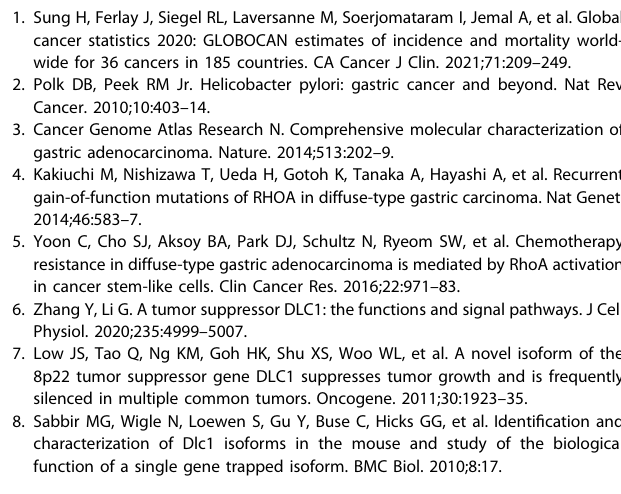
Fig. 6 DLC1 interacts with CagA. A Scheme of DLC1 and CagA expression constructs. Legend: SAM = sterile-alpha motif, RHO-GAP = RHO GTPase-activating protein (catalytic domain for RHO inhibition); START = StAR-related lipid-transfer (domain), Cav1bm = caveolin-1 binding motif, EPIYA = Src kinase tyrosine phosphorylation motif; grey = multimerisation domain. B , C CagA interacts with DLC1. HEK293T cells were transfected with CagA-FL (aa 1-1216), CagA-NT (aa 1-877), or CagA-C (aa 838-1216), combined with DLC1v1 or v4 expression plasmids, respectively. CoIP was performed on cell lysates using Abs against CagA, DLC1 (v1) and FLAG (v4). Quantitative analyses ( B ) and representative images ( C ) from Western blots (Source fi le: “ Original Western Blots ” page 15 – 17). OD values from gels were normalised to ERK1/2 (as loading control) and presented as -fold ± S.E. (* p < 0.05 vs. bead control, 2way-ANOVA with Bonferroni post-tests, n = 3 per plasmid). D HEK293T cells were transfected with CagA-FL (aa 1-1216) in combination with DLC1v1 or v4 plasmids. Representative images from PLA microscopy.